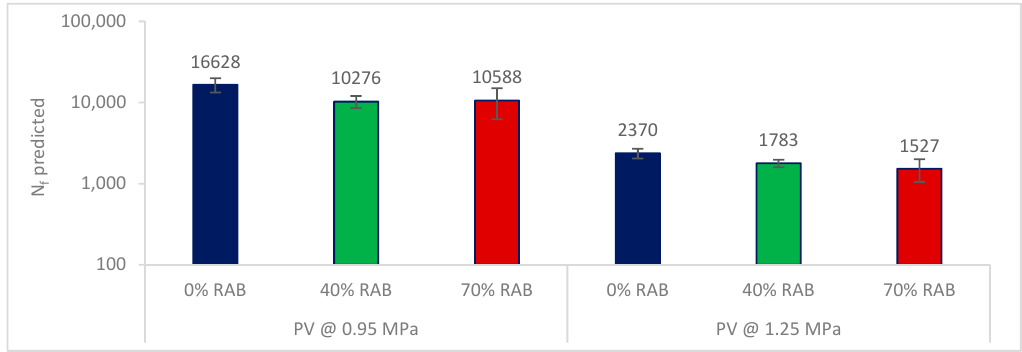
Figure 13. Predicted fatigue life of the mortar scale, per mixture, for the two stress levels based on the PV (Equation (5)).